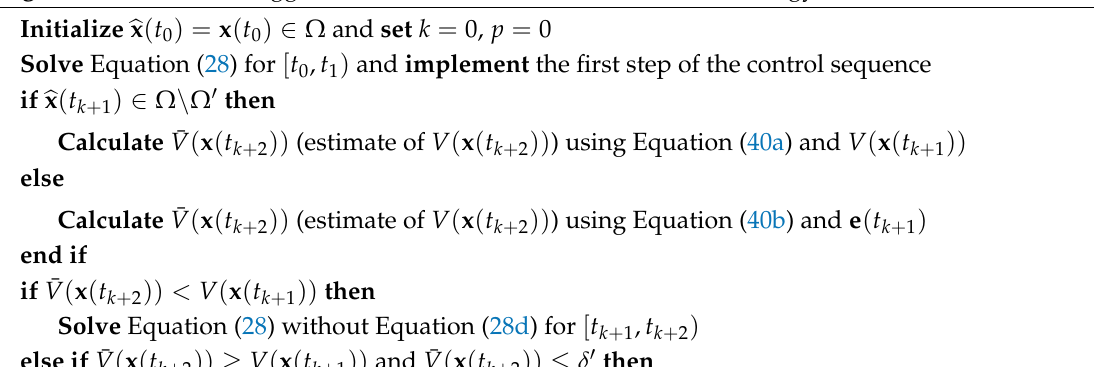
Algorithm 1 and the flowchart in Figure 1 summarize the proposed forecast-triggered communication strategy. The notation ¯ V ( x ) is used to denote the upper bound on V ( x ) resulting from the forecast strategy. Algorithm 1. Forecast-triggered sensor–controller communication strategy